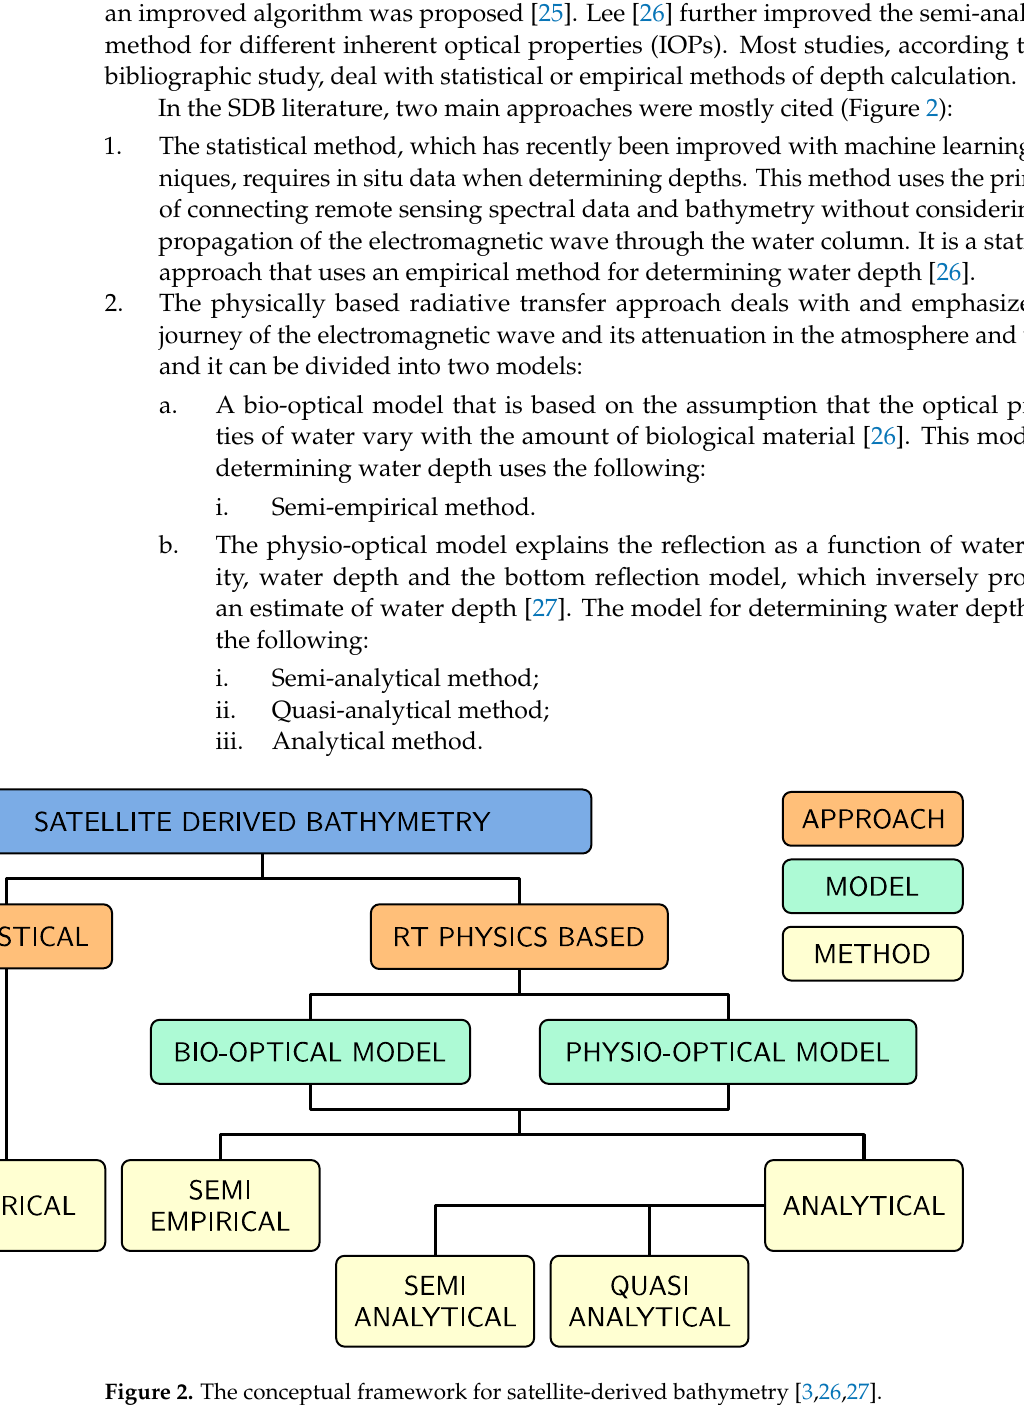
Figure 2. The conceptual framework for satellite-derived bathymetry [3,26,27].